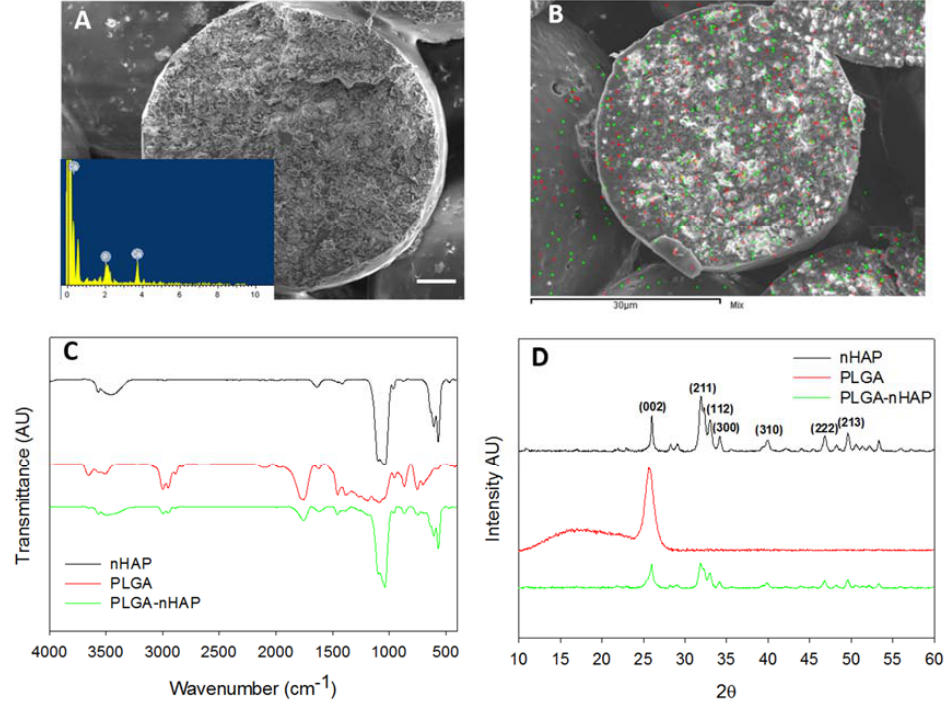
Figure 4. Characterization of cavity-shaped PLGA-nHAP microsphere scaffolds through SEM observation of scaffold cross section ( A , bar = 50 μ m), elemental mapping of Ca (green dots) and P (red dots) atoms ( B ), FTIR ( C ) and XRD ( D ).